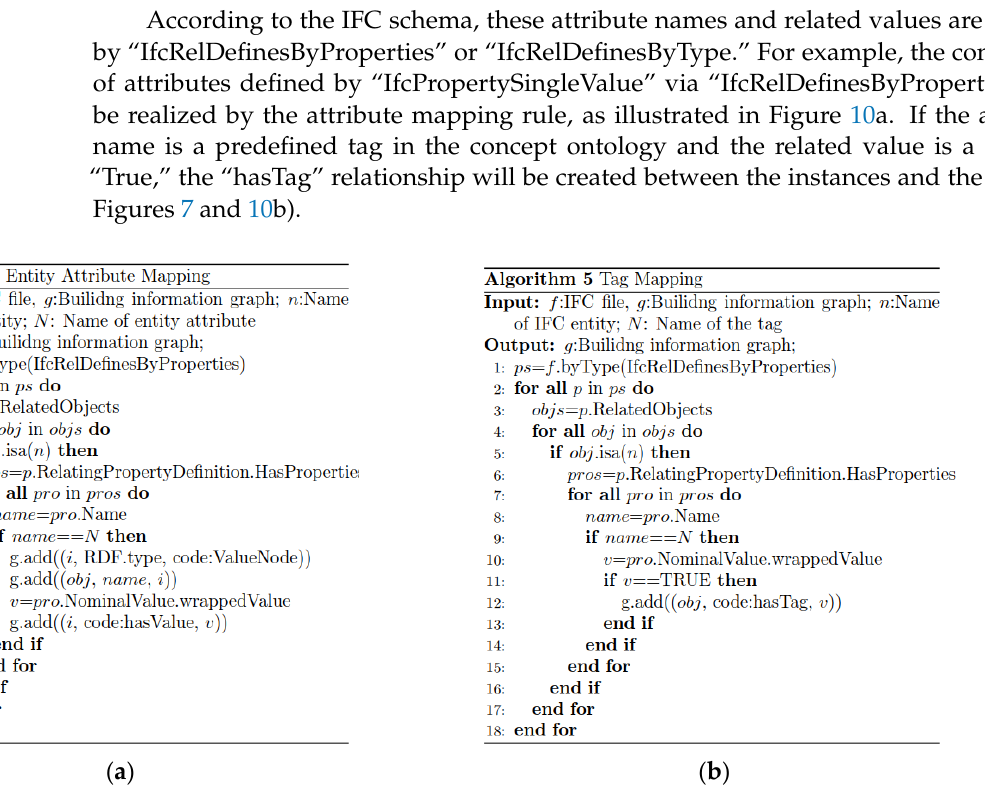
Figure 10. Packaged algorithms of attribute mapping rule development: ( a ) entity attribute mapping rule for the “IfcPropertySingleValue” defined via “IfcRelDefinesByProperties”; ( b ) tag mapping rule.